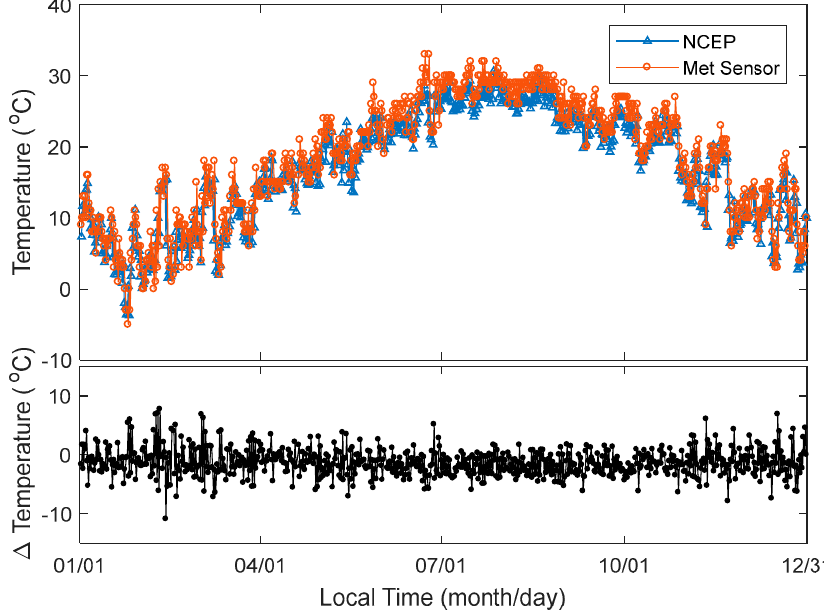
Figure 3. Temperature near CORS Taiz station interpolated by NCEP re-analysed dataset and measured by meteorological sensors at HOJA (top panel) with 12 h intervals over the whole of 2016; and difference of temperature from two approaches (bottom panel) over the whole of 2016.